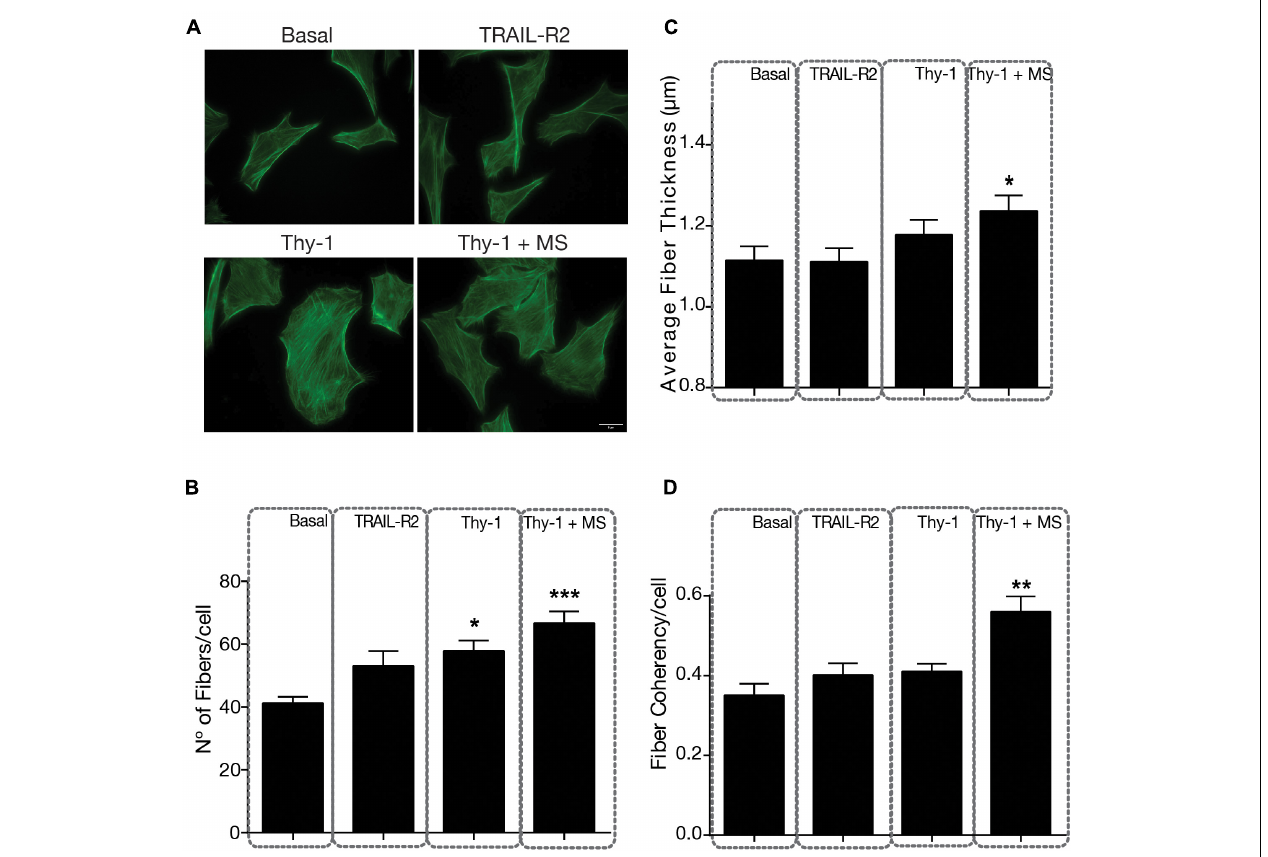
FIGURE 2 | Indirect Immunofluorescence of stress fibers in DITNC1 cells. (A) Cells were plated on coverslips and incubated with serum-free medium for 30 min, and then stimulated as indicated in Figure 1 , for 5 min. Stress fibers were labeled with phalloidin/FITC (green). Magnification bar = 8 µ m. Values in the graph are (B) Number of stress fibers per cell, (C) Average thickness ( µ m) of stress fibers per cell, and (D) Stress fiber coherency (alignment) per cell. Values in histograms and error bars represent mean + s.e.m. from at least 30 cells that were measured per condition in each experiment ( n = 3). Statistical significance was calculated using Kruskal–Wallis non-parametric test with Dunn’s multiple comparison. MS, Mechanical Stress. * p < 0.05, ** p < 0.01, and *** p < 0.001, compared with basal